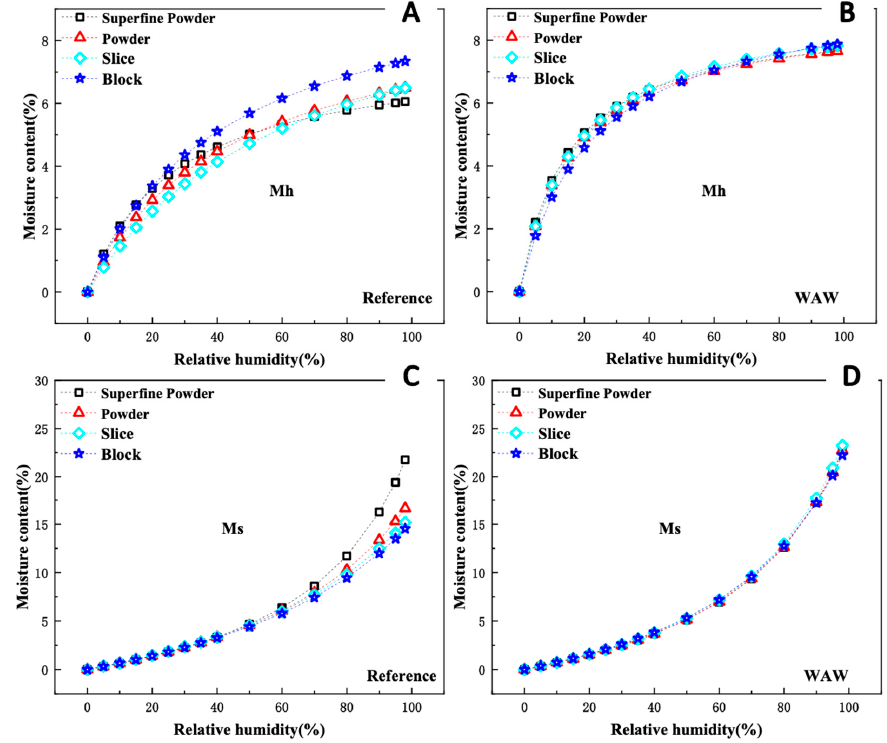
Figure 5. M h of reference samples ( A ) and WAW samples ( B ) in desorption process. M s of reference samples ( C ) and WAW samples ( D ) in desorption process.